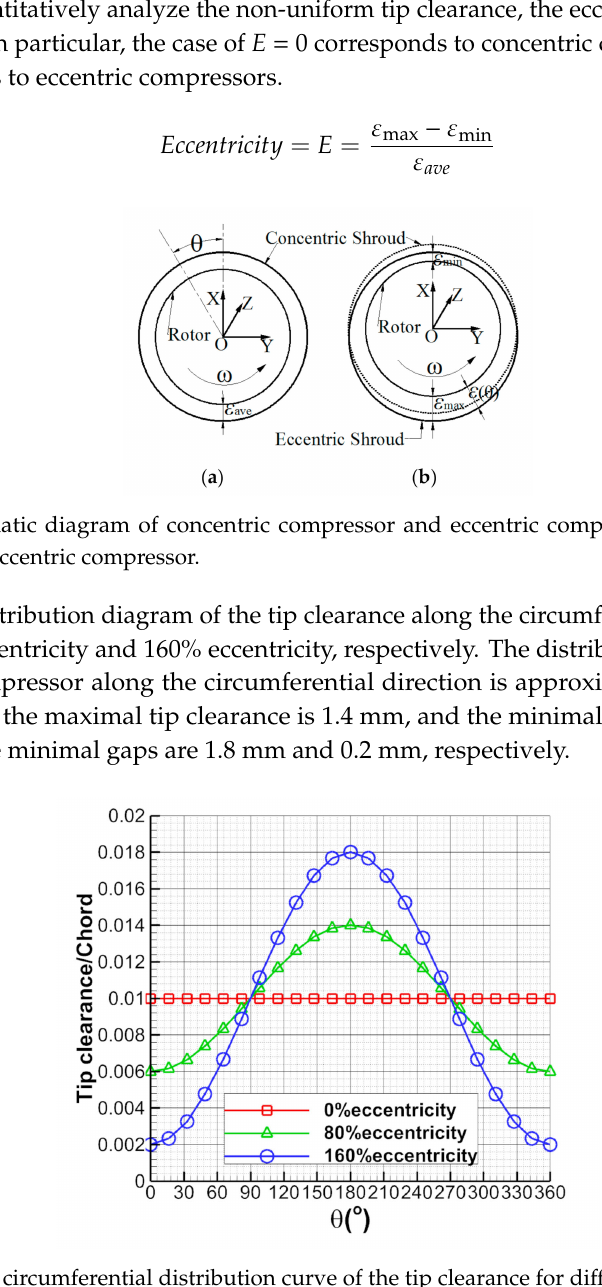
Figure 4. The circumferential distribution curve of the tip clearance for di ff erent